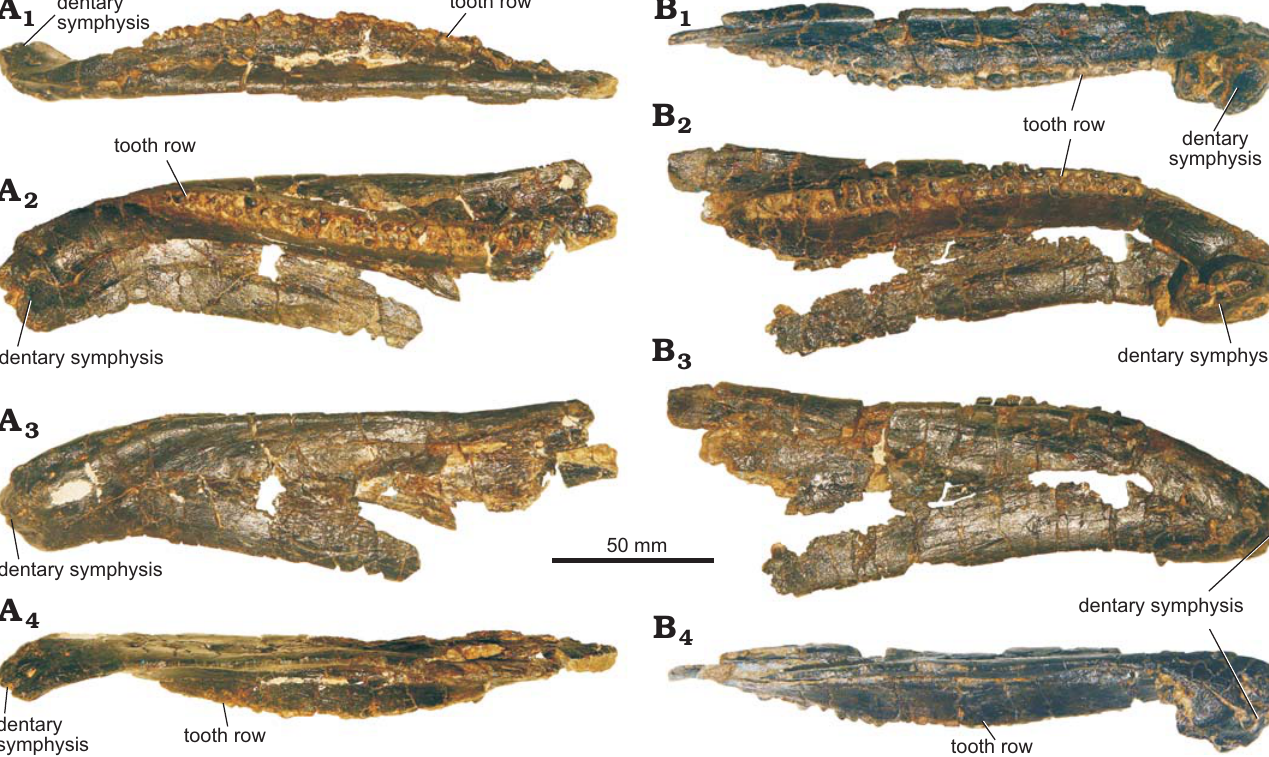
Fig. 9. Stegosaur GPDM 178, near Giffen, Cascade County, Montana. A . Left dentary in dorsal (A 1 ), medial (A 2 ), lateral (A 3 ), and ventral (A 4 ) views. B . Right dentary in dorsal (B 1 ), medial (B 2 ), lateral (B 3 ), and ventral (B 4 ) views.